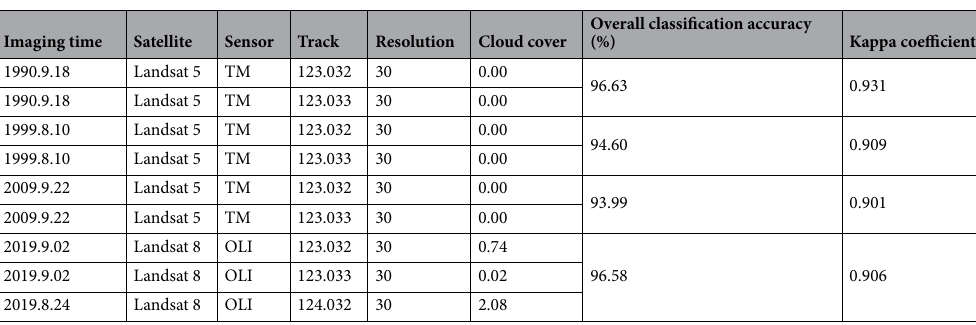
Table 3. Landsat image data information.